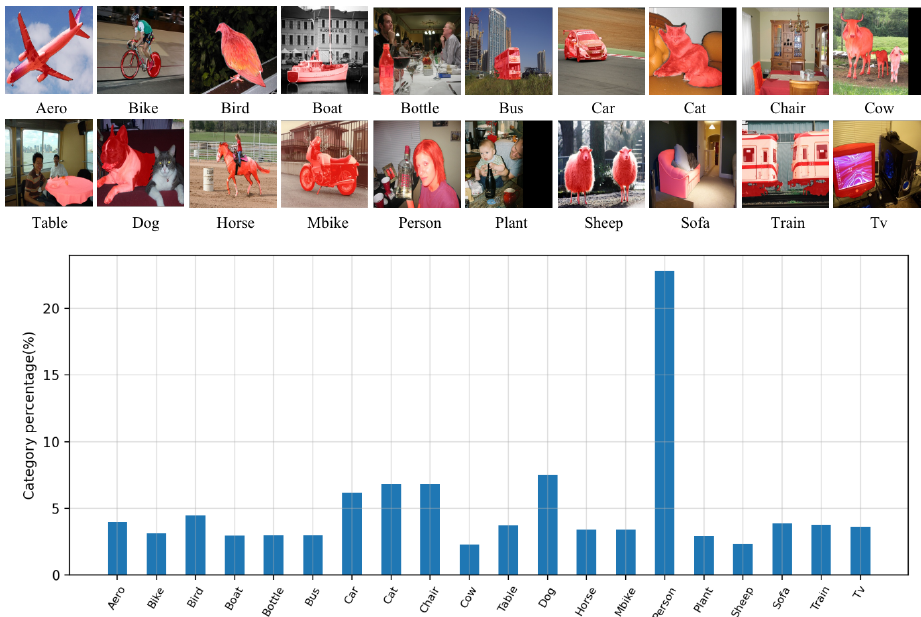
Figure 8. Example images and their corresponding segmentation in PASCAL-5 i . Bars at the bottom indicate the percentage of the number of different categories in PASCAL-5 i